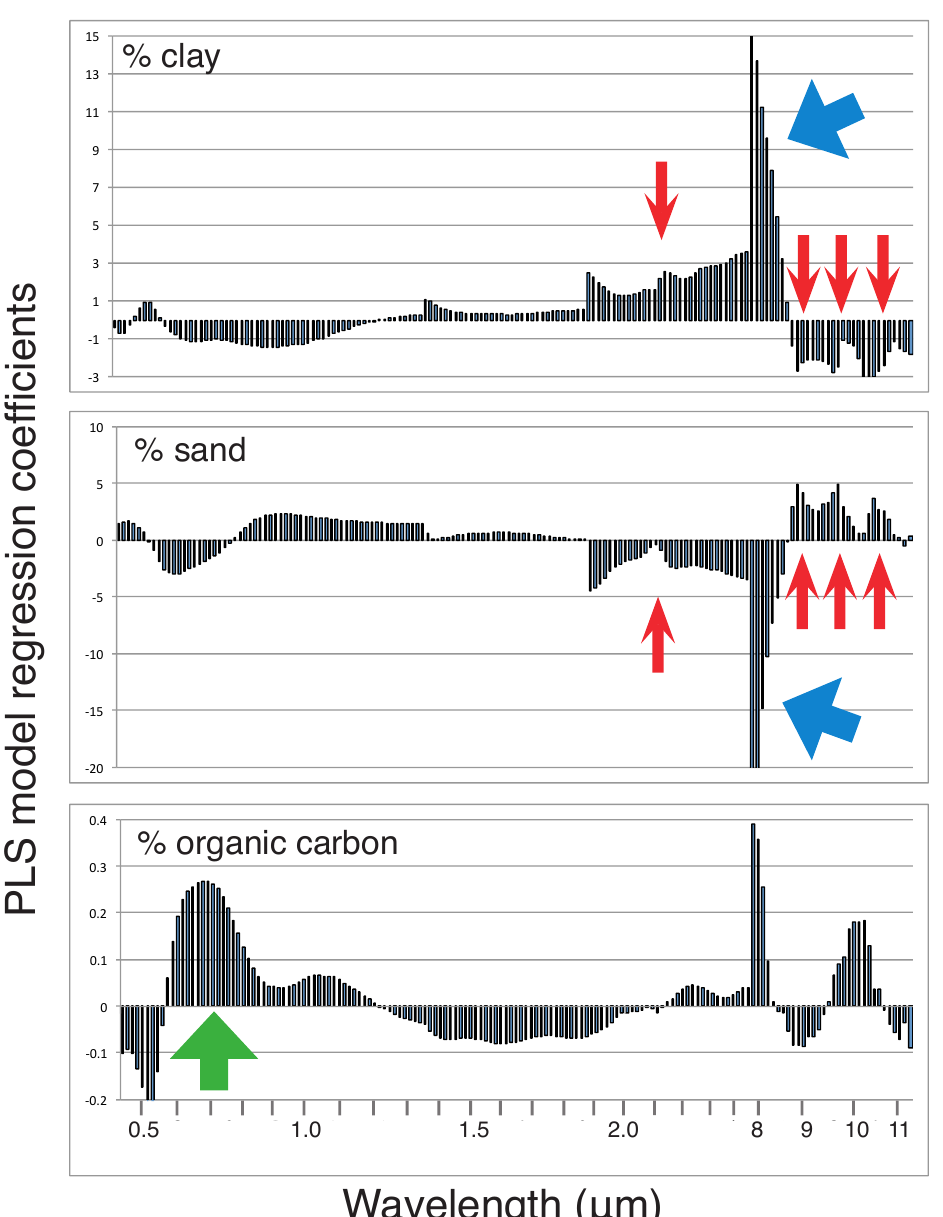
Figure 9. PLSR regression coefficients for the combined VNIR-SWIR-TIR models for the prediction of clay, sand and organic carbon. The arrows indicate the corresponding spectral features (red: kaolinite; blue: quartz; green: organic